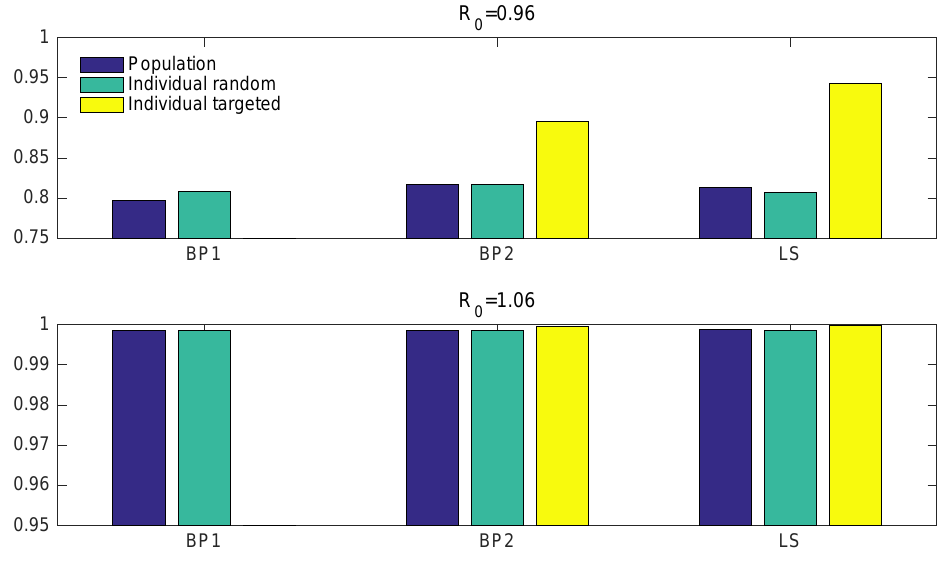
Figure 9. The reduction rate of the three models when the control effort is 20%. The upper panel is for R = 0.96 and the bottom panel is for R = 1.06. The blue bars denote population control, green bars 0 0 denote random individual control, and the yellow bars denote targeting individual